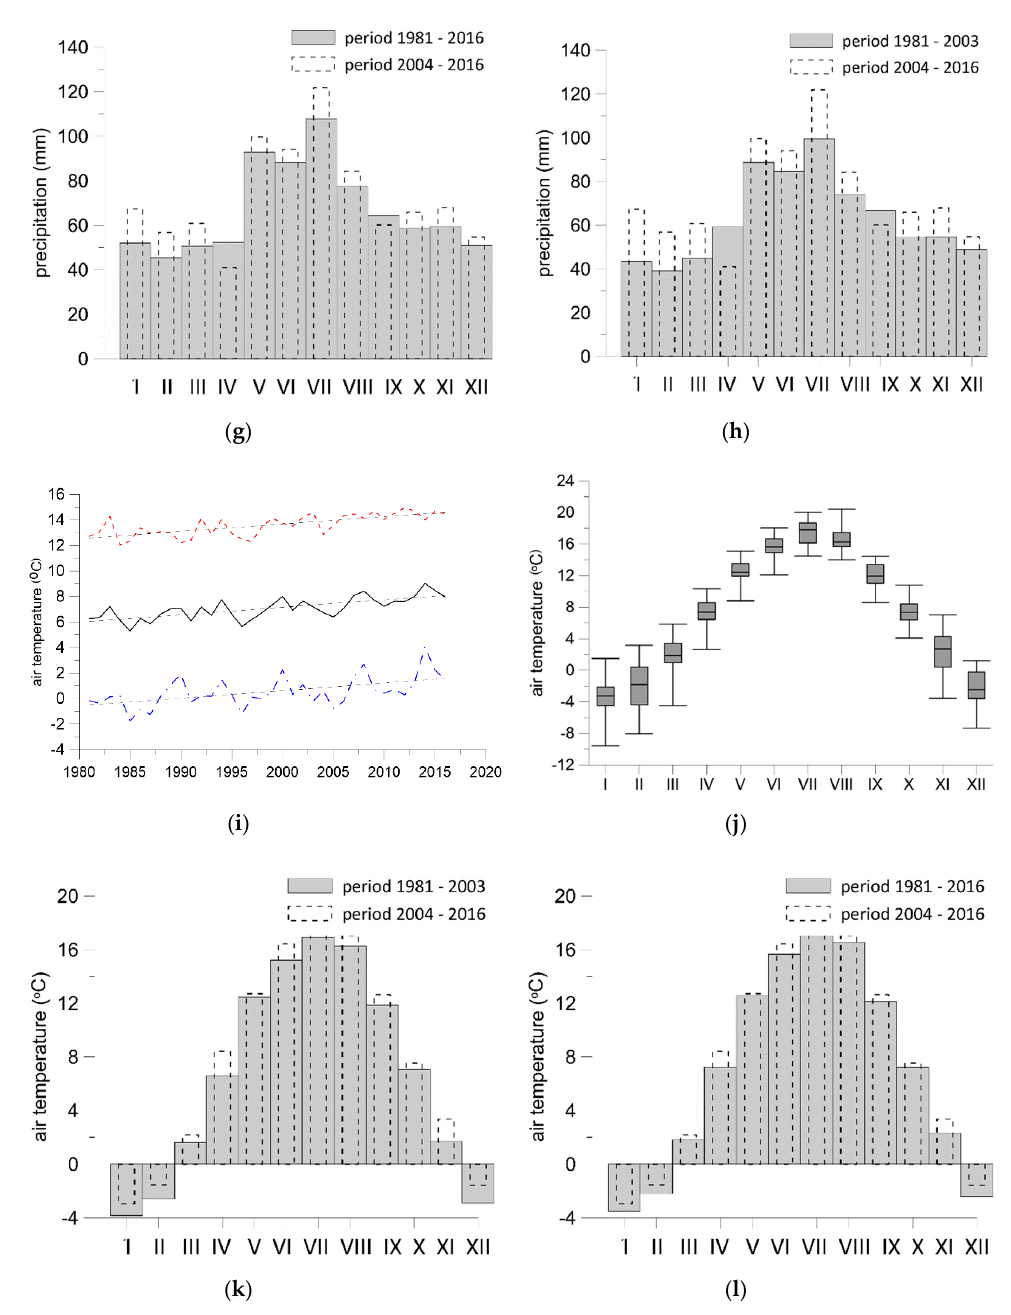
Figure 6. ( a – i ) Analysis of the hydrometeorological data–Ipoltica River basin. ( a ) time series of annual